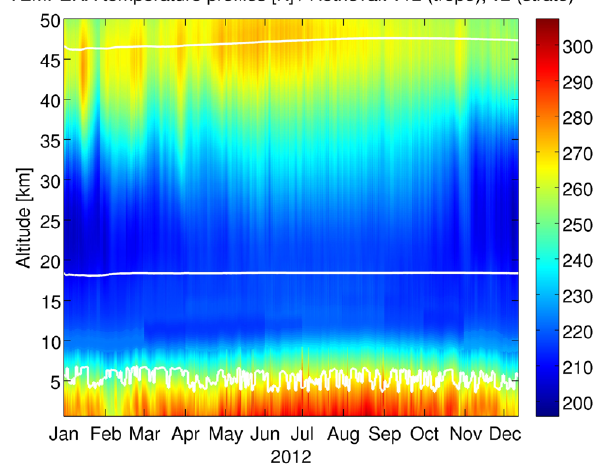
Fig. 6. Temperature profiles derived from TEMPERA from ground to 50km from 1 January to 13 December 2012. The white lines indicate the region where MR=0.6.